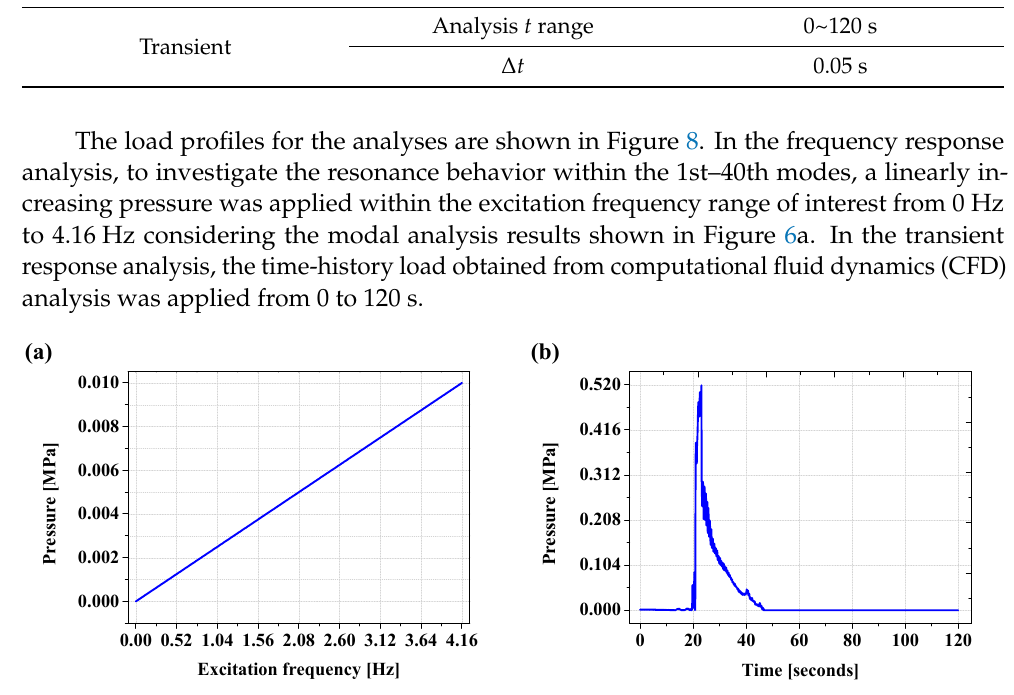
Figure 9. Stiffened plate with pressure applied to bottom and retained nodes. To calculate the proportional damping coefficients α and β used in Equation (8), we used the 1st and 2nd natural frequencies already calculated in the previous modal analysis. Using Equation (9), we could calculate these coefficients as